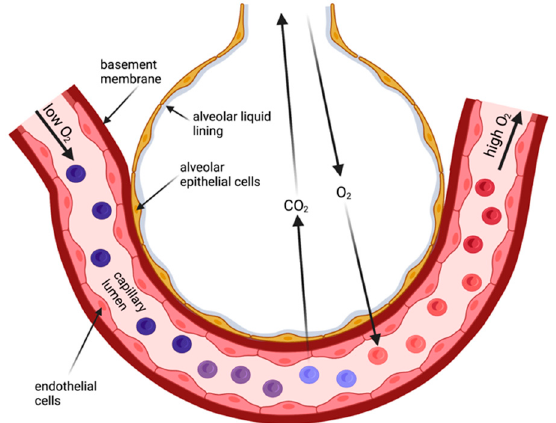
Figure 1. Schematic drawing of the alveolar region forming the air–blood barrier. The air–blood barrier comprises a liquid layer covering the alveolar epithelium, the alveolar epithelium, the basement membrane, and the endothelial cell layer. CO 2 and O 2 cross the air–blood barrier by diffusion (created with BioRender.com).